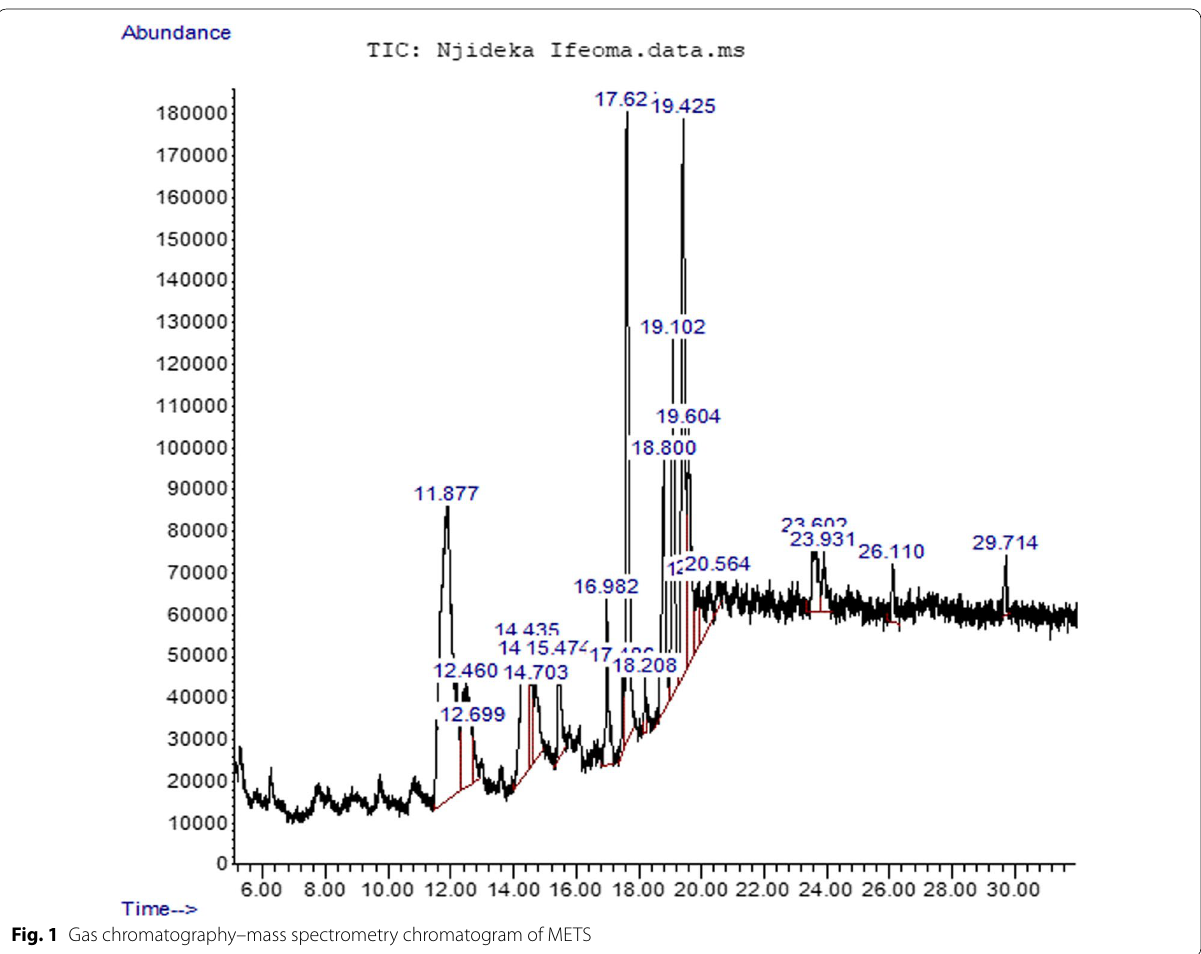
Fig. 1 Gas chromatography–mass spectrometry chromatogram of METS